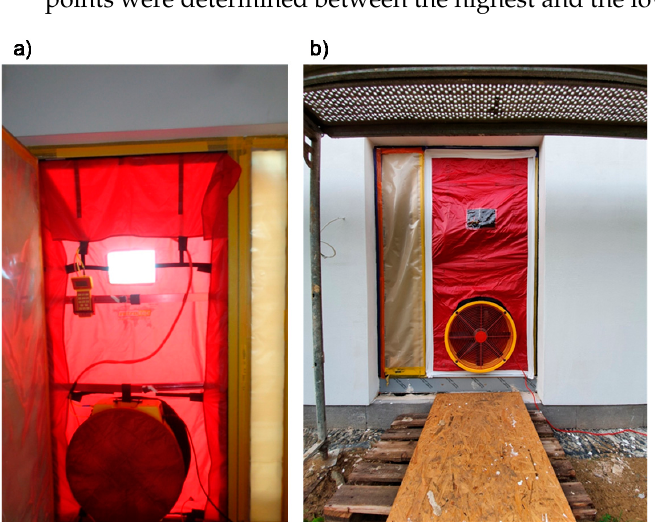
Figure 6. Blower door with an installed fan and measuring system ( a ) view from the inside of the tested object, ( b ) view from the outside of the tested object.